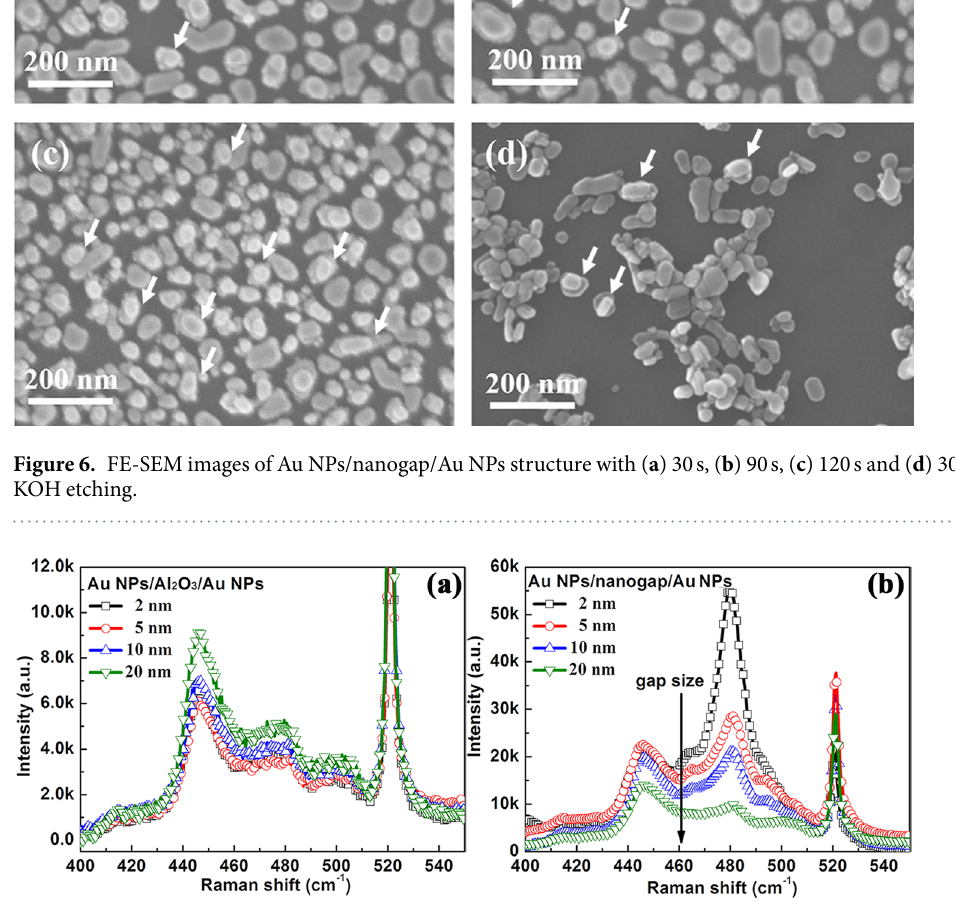
Figure 7. Raman spectra of MB molecules adsorbed on ( a ) Au NPs/Al 2 O 3 /Au NPs and ( b ) Au NPs/nanogap/ Au NPs with various Al 2 O 3